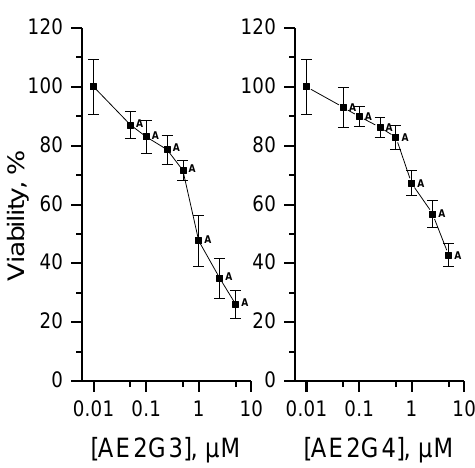
Figure 3. Viability of HeLa cells exposed to AE2G3 and AE2G4 dendrimers for 72 h. The point 0.01 µM corresponds to untreated control (log scale). Data are presented as Mean ± Standard Deviation. A—significant difference to untreated control (Newman–Keuls post hoc test), p < 0.001. n for each concentration = 18, n of untreated control = 72.